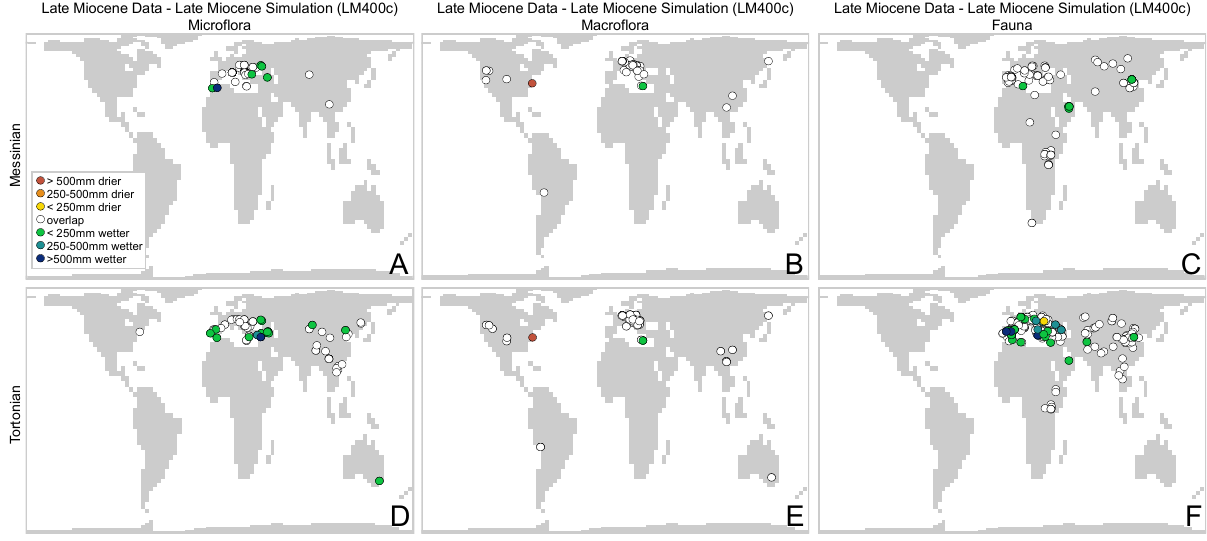
Fig. 13. Results from the model–data comparison for mean annual precipitation, late Miocene data (LM400c).